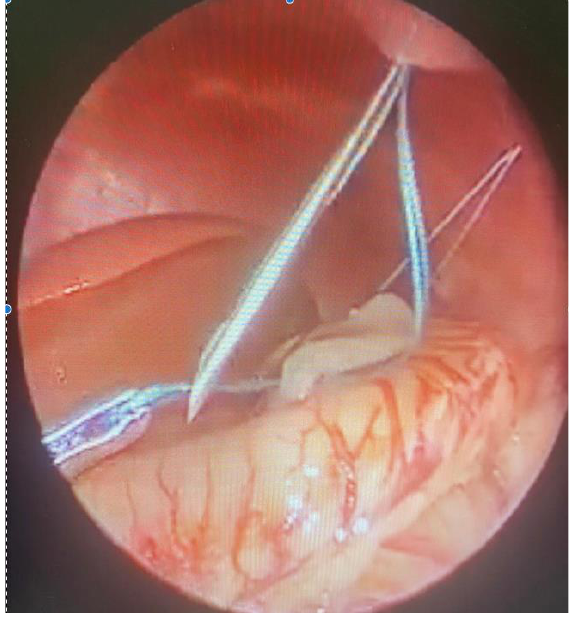
Figure 4. Intraoperative image: intracorporeal. Suture insertion via 14 G needle.